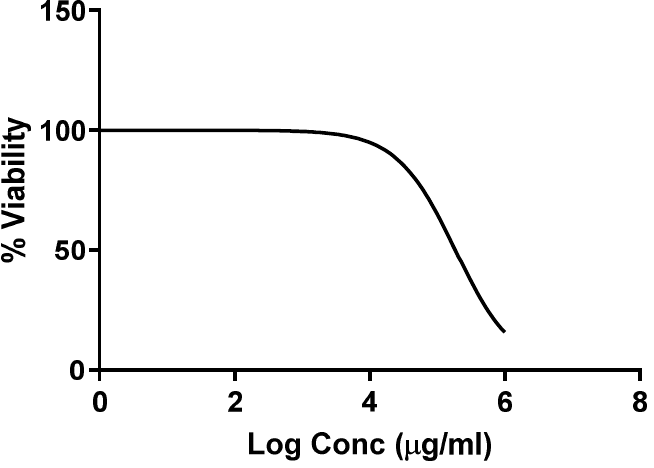
Figure 4. Cytotoxicity curve of Salvadora persica methanol extract (CC 50 of 185.960 ± 0.1 µ g/mL). The results are presented as the mean ± SD.